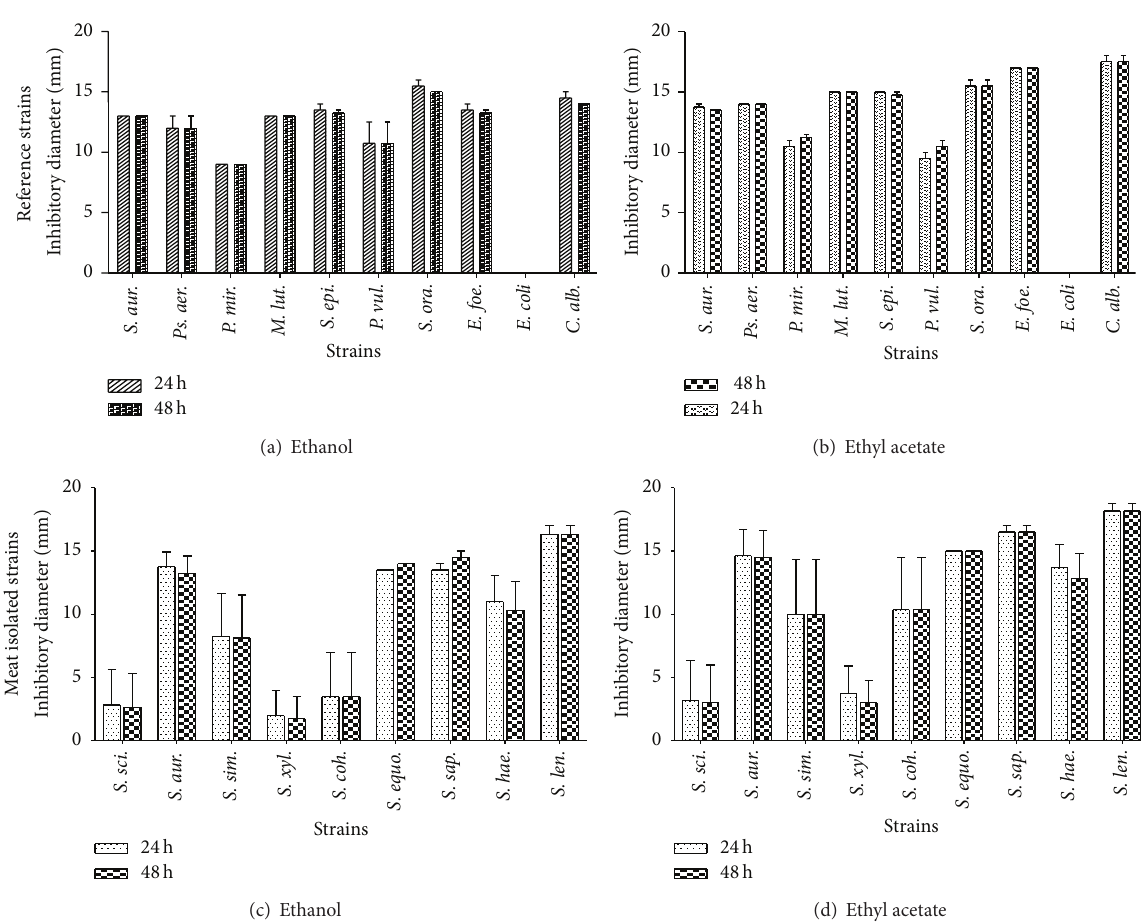
Figure 2: Medium inhibitory diameter zone of C. nitida extracts on reference and meat isolated Staphylococcus strains after 24 h and 48 h of incubation. Reference strains are the following: S. aur. : Staphylococcus aureus , M. lut. : Micrococcus luteus , S. epi. : Staphylococcus epidermidis